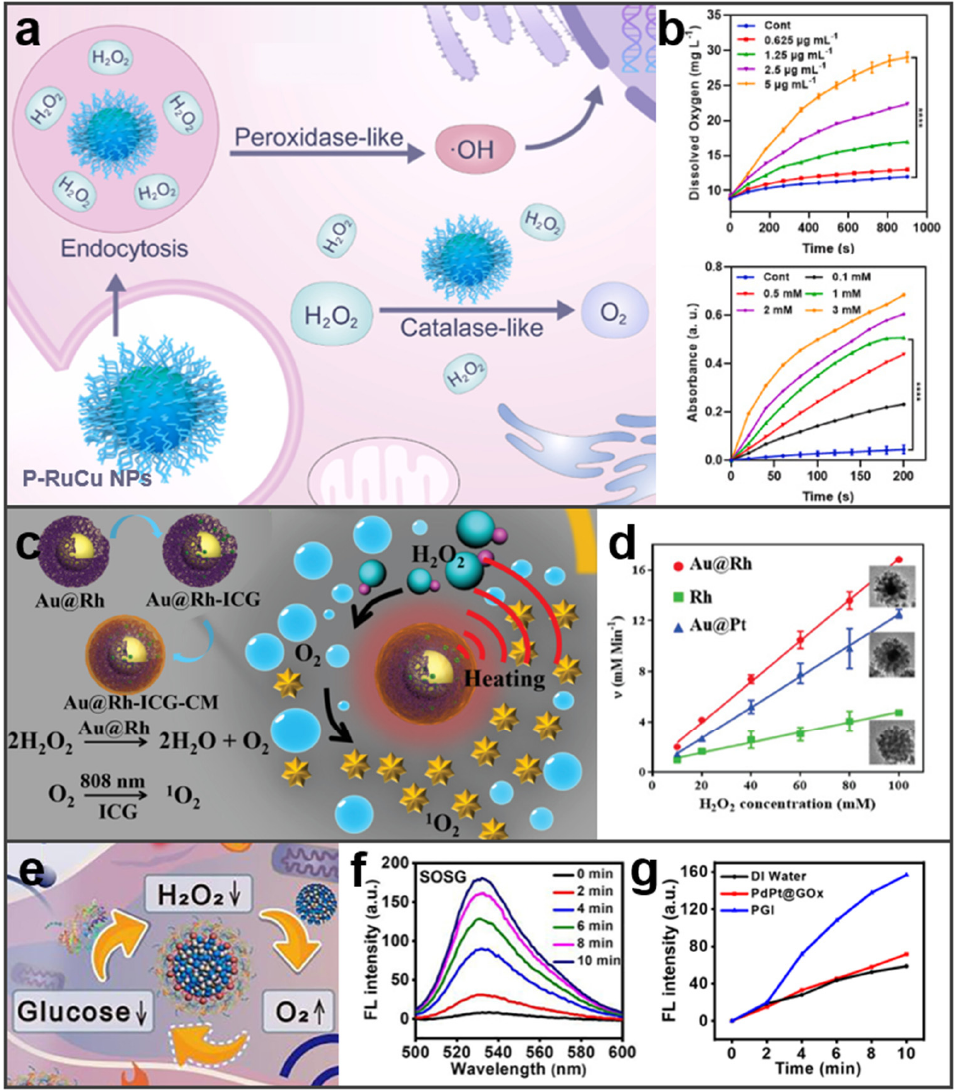
Figure 5. Expression of enzyme-like activity of BMNs. ( a ) Scheme illustration of RuCu NPs for en- hanced cancer radiotherapy. Reprinted with permission from Ref. [96]. ( b ) Dual enzyme-like activ- ities of RuCu NPs. Reprinted with permission from Ref. [96]. Copyright © 2022 Elsevier Ltd. ( c ) The associated major mechanistic pathways of Au@Rh ICG-CM in cancer therapy. Adapted with per- mission from Ref. [70]. ( d ) The velocity of the catalytic reaction. Reprinted with permission from Ref. [70]. Copyright © 2020 John Wiley & Sons, Inc. ( e ) Scheme diagram to show the catalytic activity of PGI. Reprinted with permission from Ref. [97]. ( f ) Fluorescence spectra of PGI NP dispersion containing SOSG. Reprinted with permission from Ref. [97]. ( g ) Fluorescence emission intensity un- der US irradiation. Reprinted with permission from Ref. [97]. Copyright © 2022 Elsevier B.V. **** p < 0.0001. 3.4. Stability Nanomaterials are inherently unstable due to their extremely high specific surface area, surface energy, and interfacial energy. However, BMNs can be synthesized to im- prove stability. BMNs with stability can be obtained by adjusting the composition, struc- ture, and shape of the two metal elements, referring to the method of improving stability by forming alloys in traditional metals [98]. The tendency of bimetallic mixing has been calculated by computer simulations, thus acquiring the most stable structure [99,100]. In Dean’s study, a database of 5454 low-en- ergy bimetallic NPs was generated and analyzed, thus they identified thermodynamically stable NPs [101]. They investigated the alloys Au–Cu, Ag–Au, and Ag–Cu with the